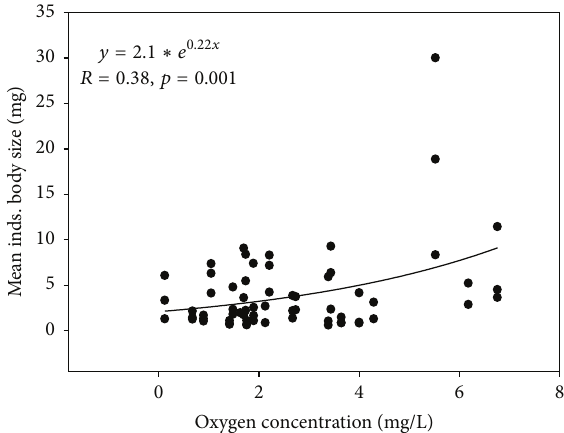
Figure 3: Exponential relationship between mean body size of polychaetes and bottom oxygen concentration at each of the 64 sites (A, B, C, and AB5 in Figure 1) in all cruises. The highest three biomass mean values at 5.76 mg/L contained the bamboo worms sampled in August 2009 (see Figure 2 and text).